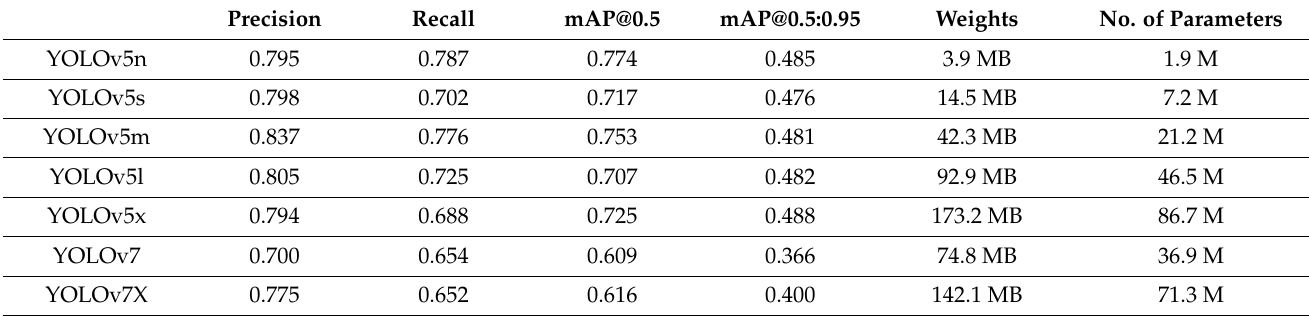
Table 1. Comparison of the various YOLOv5 versions for PPE detection.